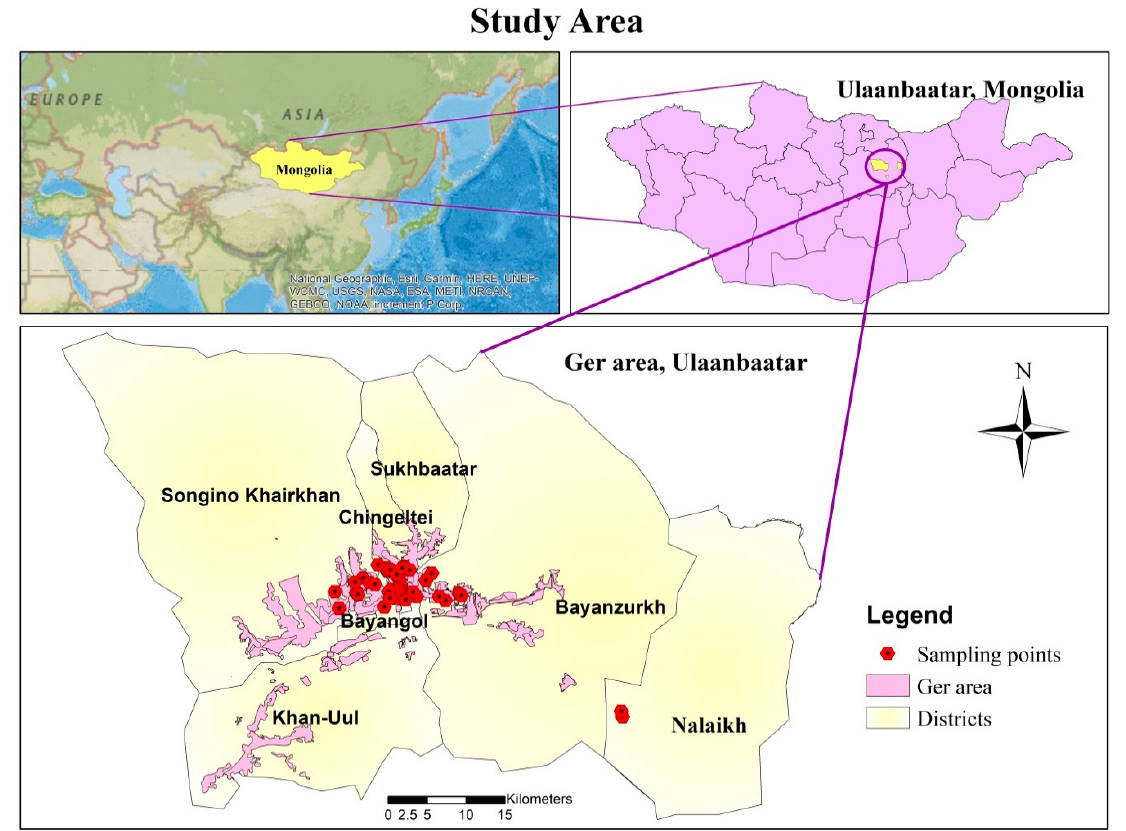
Figure 1. Location of sampling points in the ger district, Ulaanbaatar, Mongolia.